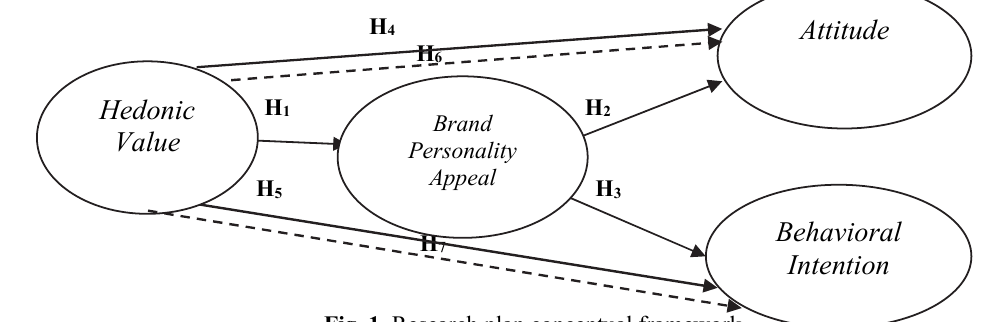
Fig. 1. Research plan conceptual